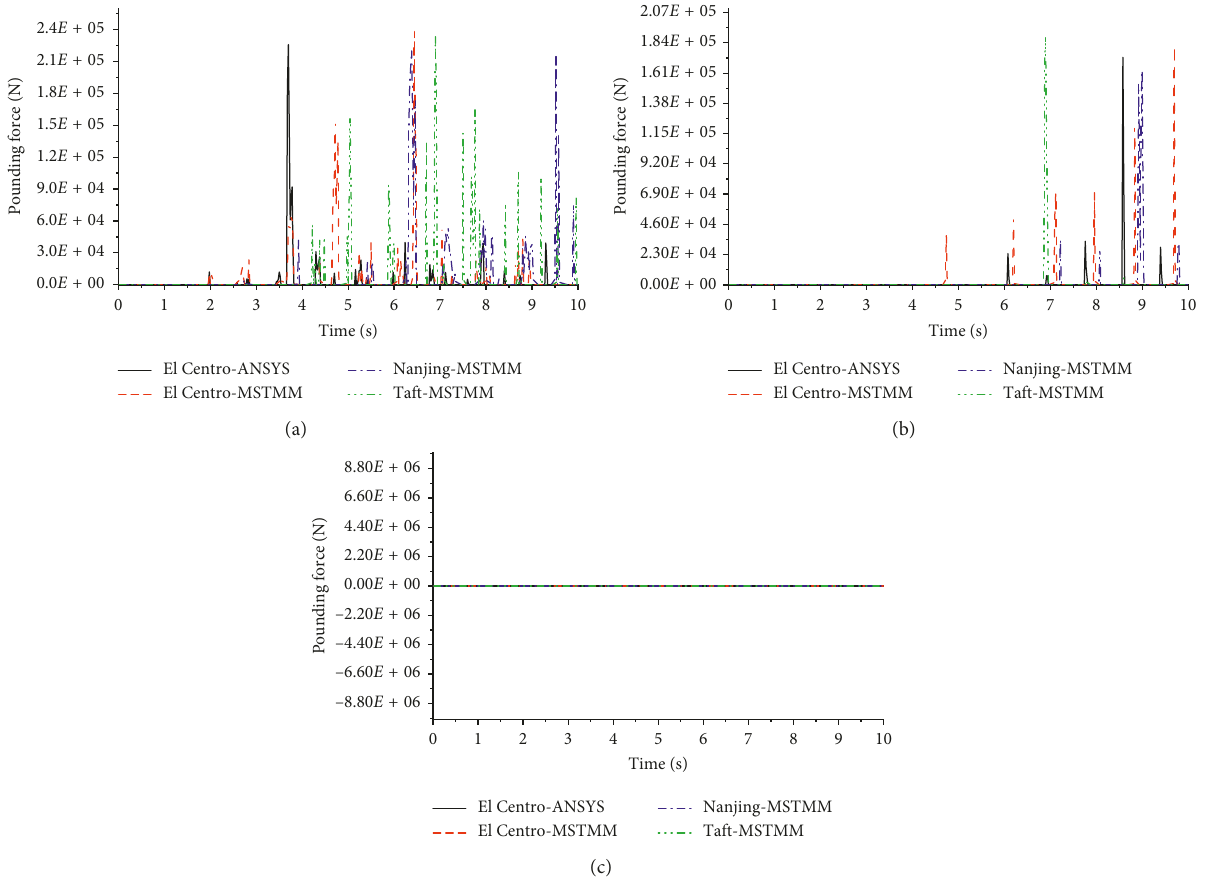
Figure 12: Time-history diagram of J and (c)